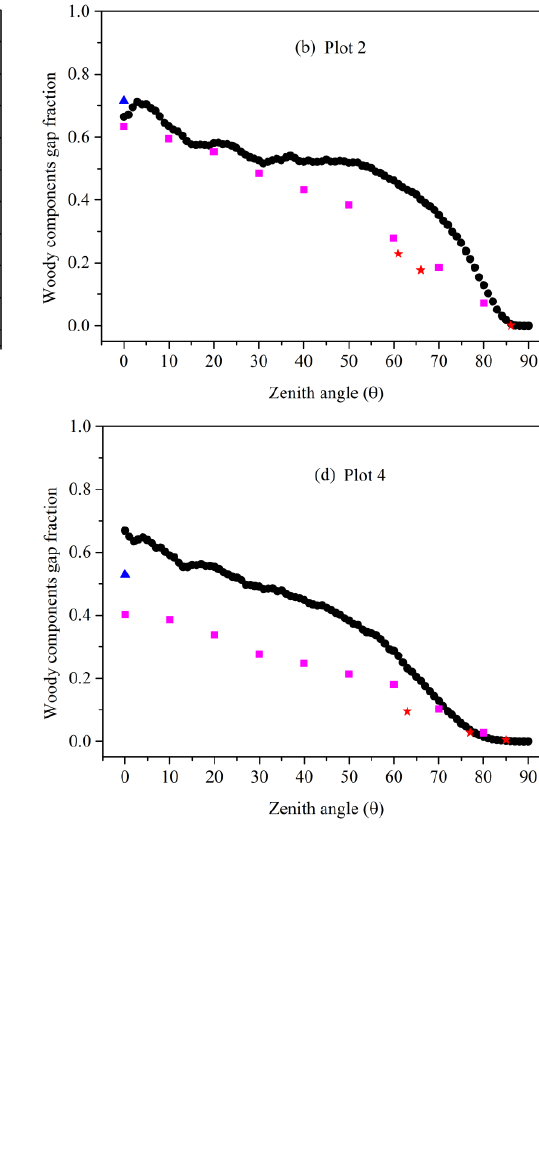
Figure 1. Canopy element gap fraction ( 𝑝 𝑒 (𝜃) ) measurements obtained from DHP, tracing radiation of canopy and architecture (TRAC), MCI, and digital cover photography (DCP) in the five leaf-on plots: ( a ) plot 1, ( b ) plot 2, ( c ) plot 3, ( d ) plot 4, and ( e ) plot 5.